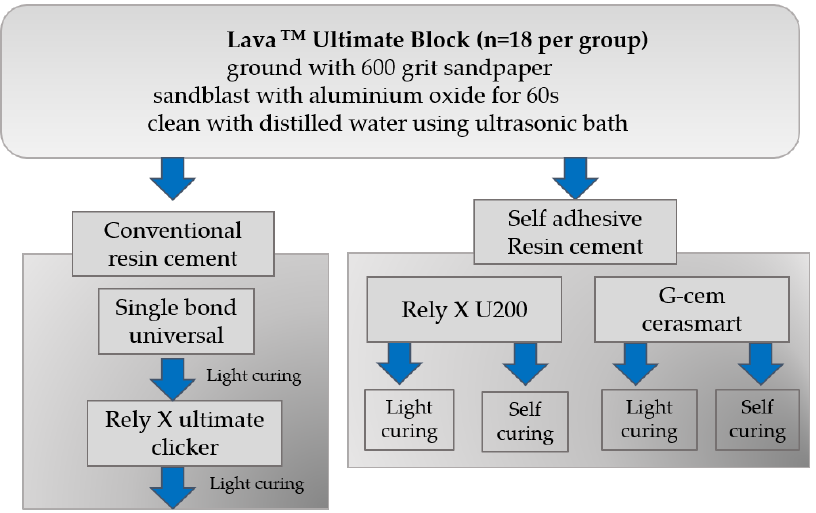
Figure 1. Flowchart of the cementation procedure on the specimens.